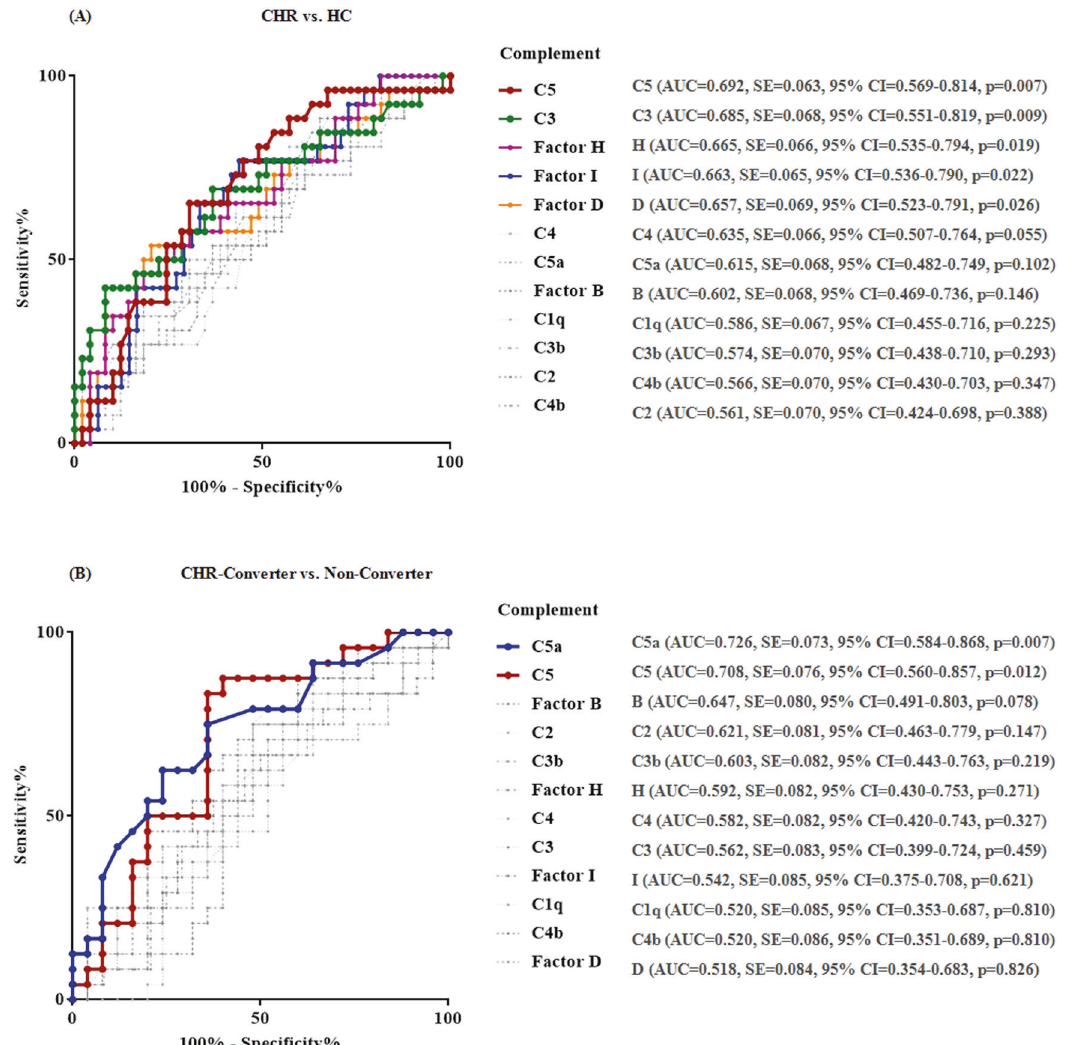
Fig. 4 Receiver operating characteristic curve pro fi les for complement factors in terms of discrimination of the CHR individuals from HC, and CHR non-converters from converters. Abbreviations: AUC an area under the Receiver operating characteristic curve, CHR Clinical high risk for psychosis, CHR-converter, CHR individuals who were converted to fully psychosis, HC Healthy